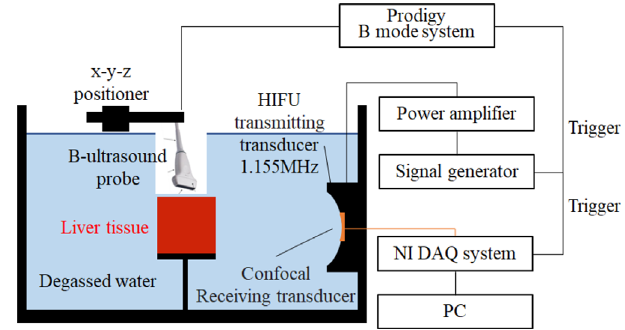
Figure 1. Experimental